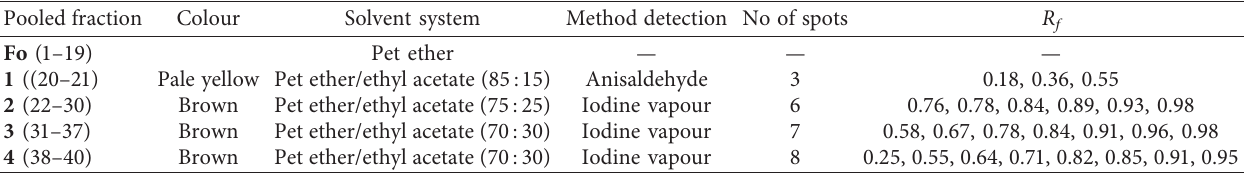
Table 1: TLC profile of fractions.